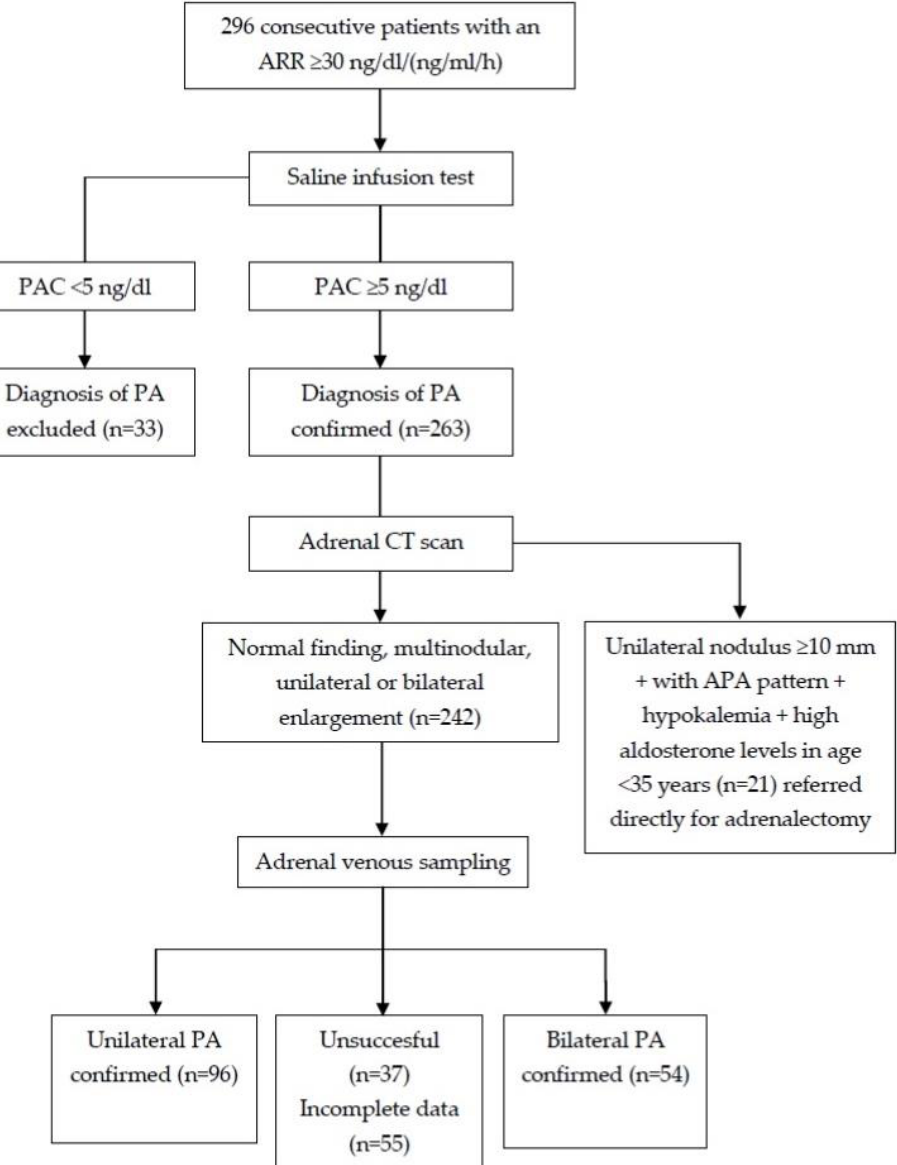
Figure 1. Flow chart of the recruitment into the development cohort. APA—aldosterone producing adenoma; ARR—aldosterone to plasma renin activity ratio; PA—primary aldosteronism; PAC— plasma aldosterone concentration.